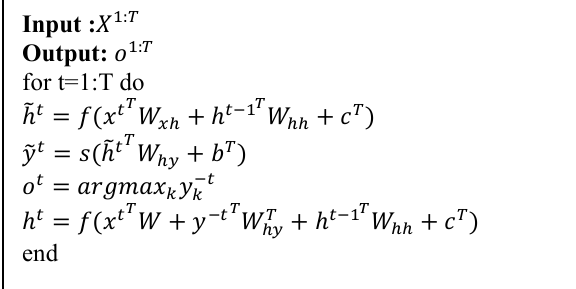
Algorithm 1. Weight Matrix propagation